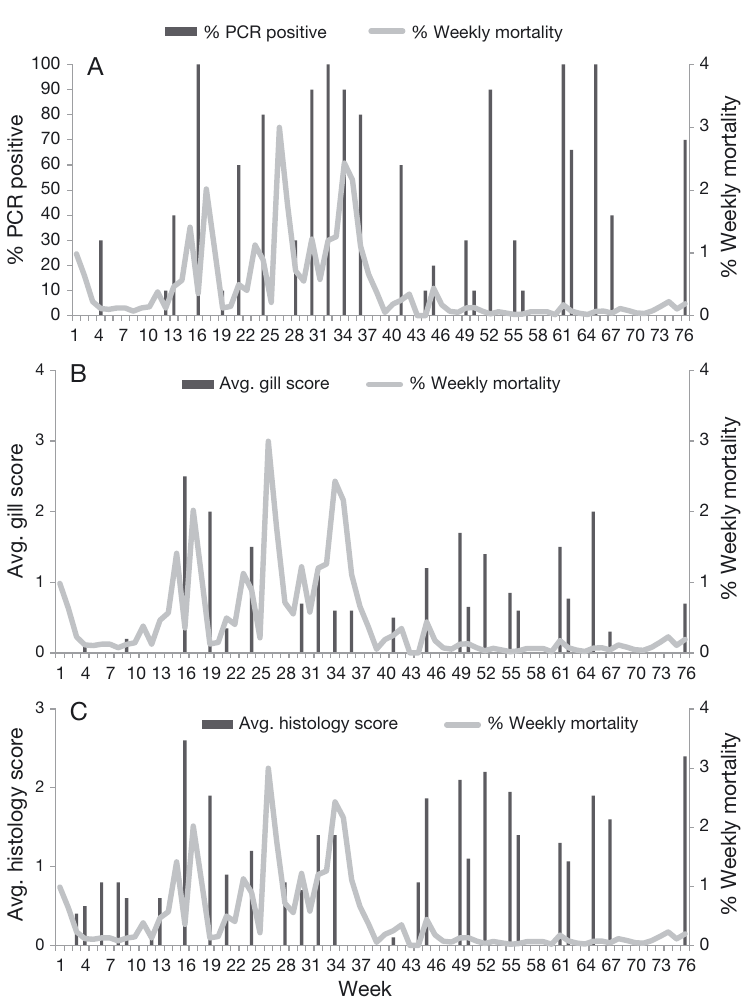
Fig. 4. Weekly mortality rates versus (A) % PCR-positive fish, (B) aver- age gill scores, and (C) average histology scores, throughout the mar- ine production cycle of Atlantic salmon during the longitudinal